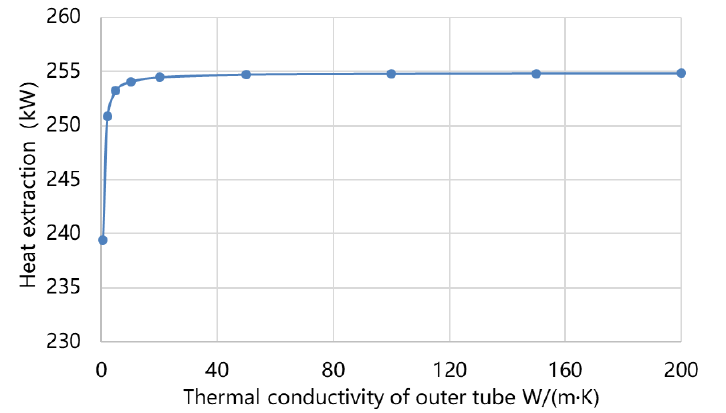
Figure 21. Effect of thermal conductivity of outer pipe on the heat extraction of